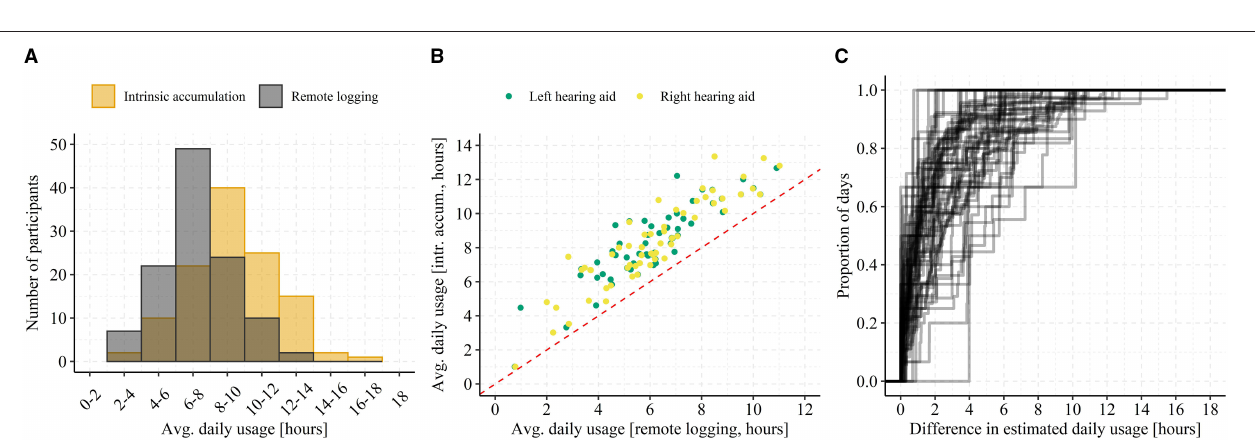
FIGURE 5 | Average daily hearing aid usage. In (A) , a histogram of average daily usage (across left and right hearing aid) binned by 2h intervals and separated by estimation method (i.e., intrinsic accumulation or remote logging). In (B) , a scatterplot of average daily usage for both left and right hearing aid from each participant with usage estimated from intrinsic accumulation on the y-axis and from remote logging on the x-axis is shown. The red dashed line represents a y = x relationship. In (C) , each trace represents one participant’s cumulative distribution function for the daily difference between usage estimates. Note that traces with big jumps (“steps”) on the y-axis are indicative of participants with only few days of data